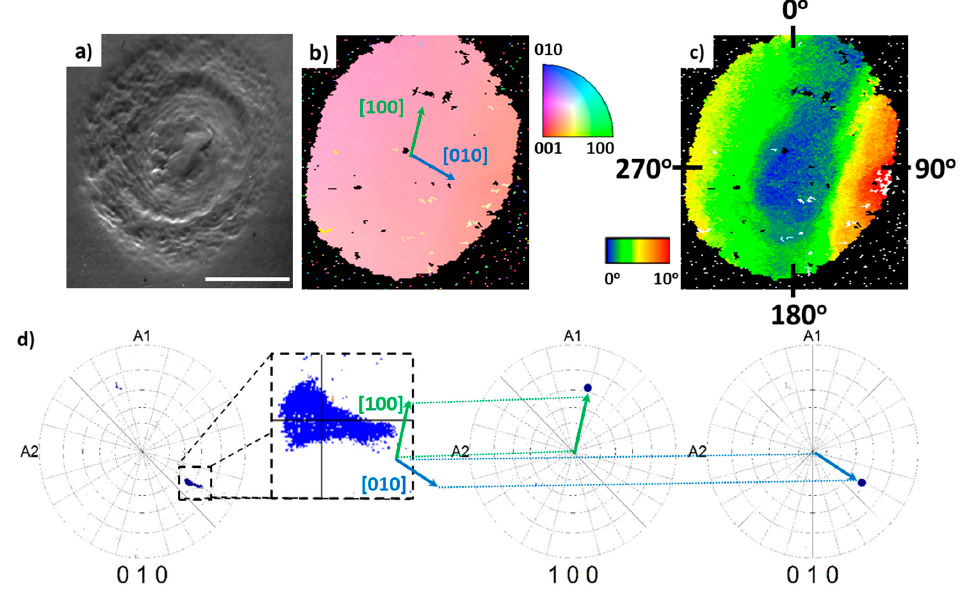
Figure 5. Sb 2 S 3 single crystal dot #2 fabricated using ‘ring’ procedure on the surface of Sb 2 S 3 glass: ( a ) SEM image, ( b ) colored inverse pole figure (IPF) map with reference vector normal to the sample surface (ND), ( c ) crystal orientation deviation (COD) map with reference to crystal orientation at the center of the dot, the marked numbers indicate positions along the crystal edges in degrees, and ( d ) pole figure (PF) maps in the (010), (100), and (001) crystallographic directions of the crystal dot. The inset represents an enlarged version of the (010) pole figure. The arrows on IPF ( b ) and PF ( d ) maps describe the direction of the lattice cell. Scale bar corresponds to 10 µm.